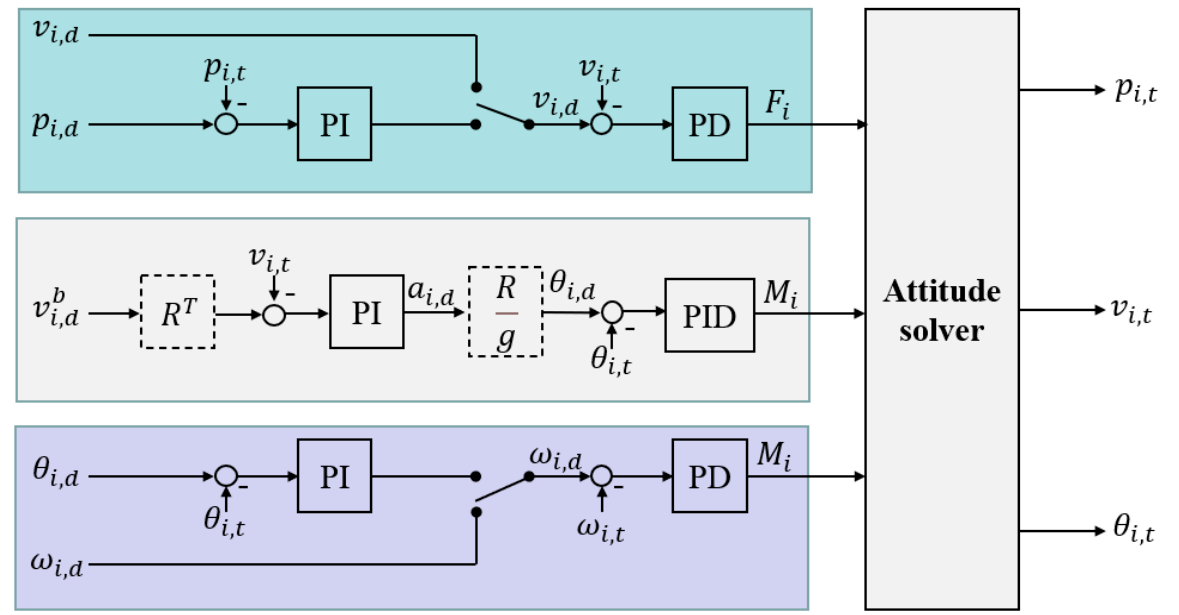
Figure 5. Design of controller for UUV attitude, angular velocity, and linear velocity.